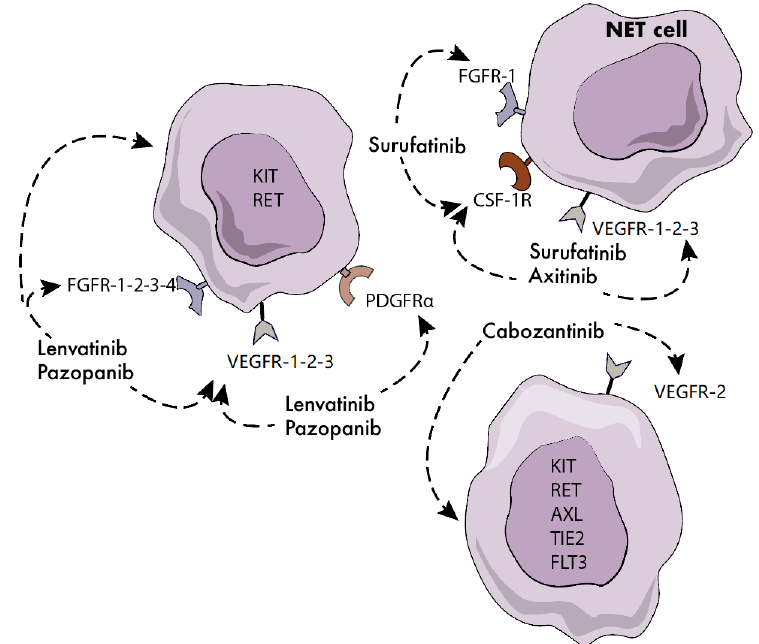
Figure 1. Molecular targets of novel tyrosine kinase inhibitors (TKIs) in neuroendocrine tumors (NETs). FGFR: fibroblast growth factor receptor; CSF-1R: colony stimulating factor 1 receptor; VEGFR: vascular endothelial growth factor receptor; PDGFR: platelet-derived growth factor.